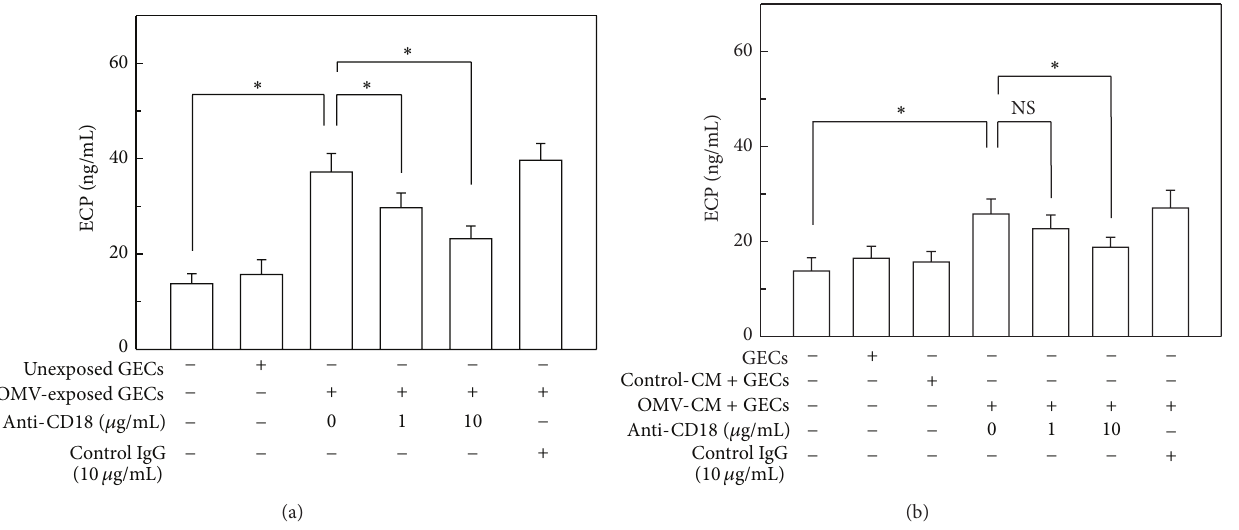
Figure 7: Effects of anti-CD18 mAb on ECP released from eosinophils. (a) Eosinophils were cocultured either with unexposed control cells or with OMV-exposed primary human gastric epithelial cells (GECs) for 24 h in the presence of either anti-CD18 mAb or mouse IgG isotype control Ab. The concentration of ECP in each culture supernatant was measured by ELISA (mean ± SEM, 𝑛 = 5 ). (b) Human eosinophils were cocultured either with OMV-CM-exposed or control CM-exposed GECs for 24 h in the presence of either anti-CD18 mAb or mouse IgG isotype control Ab. The concentration of ECP in each culture supernatant was measured by ELISA (mean ± SEM, 𝑛 = 5 ). ∗ 𝑃 < 0.05 compared with unstimulated control; NS, statistically